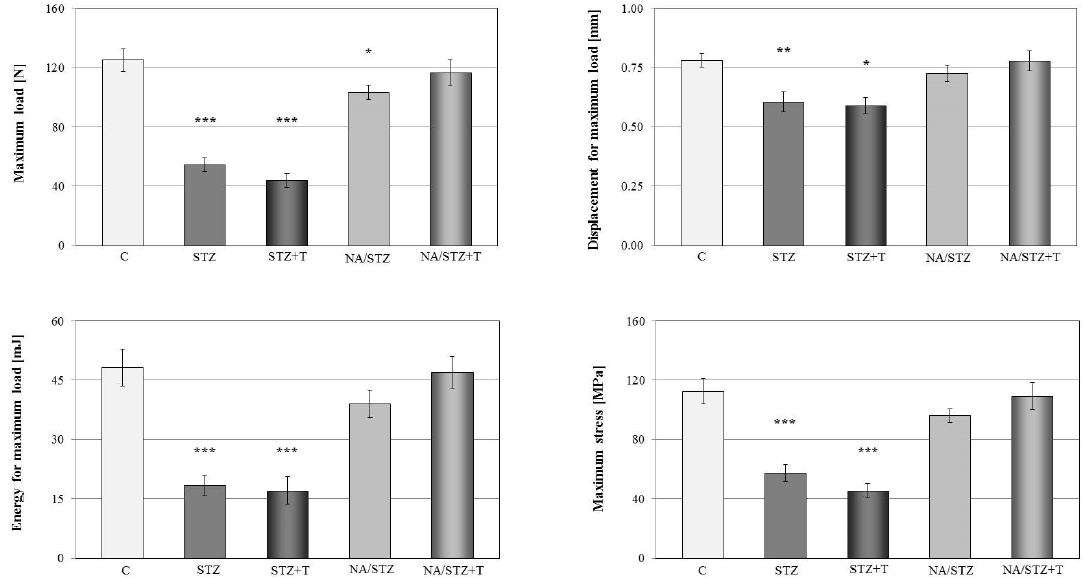
Figure 2. Effect of trigonelline (T; 50 mg/kg p.o. for four weeks) on mechanical properties of the tibial metaphysis (parameters for the maximum load point) in rats treated with streptozotocin (STZ) or nicotinamide and streptozotocin (NA/STZ). Results are presented as means ± SEM ( n = 7–10). Kruskal–Wallis ANOVA followed by Mann–Whitney U test were used for evaluation of the significance of the results. * p < 0.05, ** p < 0.01, *** p < 0.001—significantly different from the control group (C). Table 3. Effect of trigonelline (50 mg/kg p.o. for four weeks) on mechanical properties of the tibial metaphysis (Young’s modulus and the parameters for the yield point and the fracture point) in rats treated with streptozotocin (STZ) or nicotinamide and streptozotocin (NA/STZ). Parameter/Group Control STZ + Trigonelline Young’s modulus (MPa) Yield point load (N) Displacement for yield point load (mm) Stress for yield point load (MPa) Fracture load (N) Displacement for fracture load (mm) Energy for fracture load (mJ) Stress for fracture load (MPa)